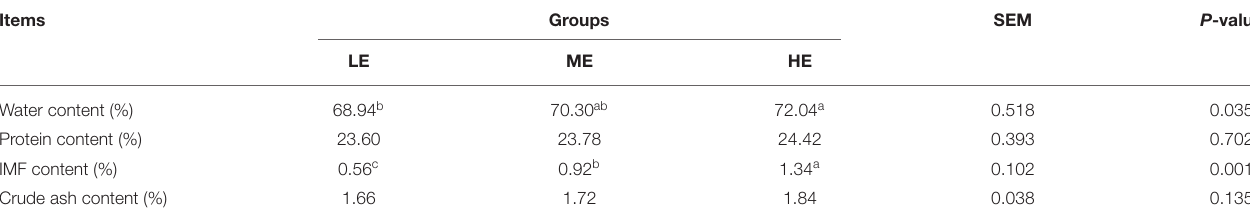
TABLE 1 | Effects of dietary energy levels on the nutritional components in the longissimus thoracis muscle of yak. Items Groups